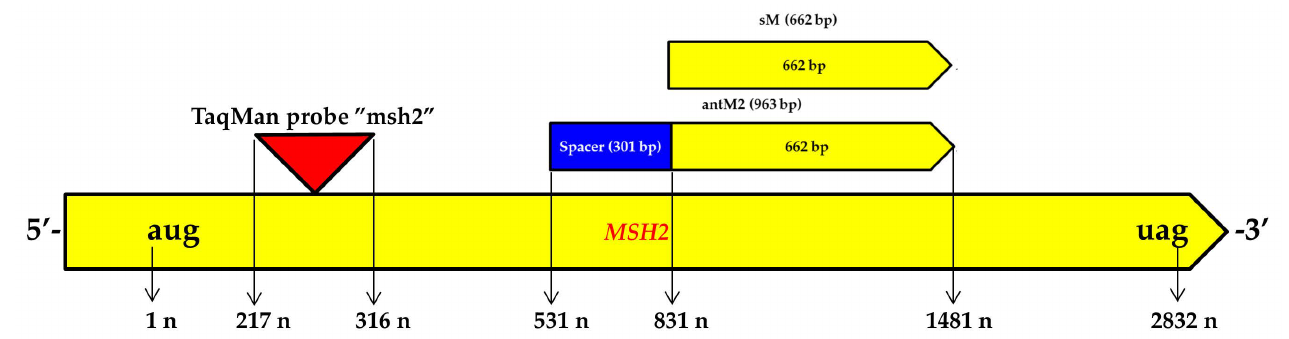
Figure 3. Scheme of the MSH2 gene transcript and target regions for RNAi and the “msh” TaqMan probe. The first nucleotide of the AUG start codon of the MSH2 gene transcript’s translated region is designated 1 n; the last nucleotide of the UAG stop codon is designated 2832 n. Arrows and numbers show the relative positions of the antM2 and sM2 sequences, as well as the “msh” TaqMan probe in the MSH2 gene transcript sequence.